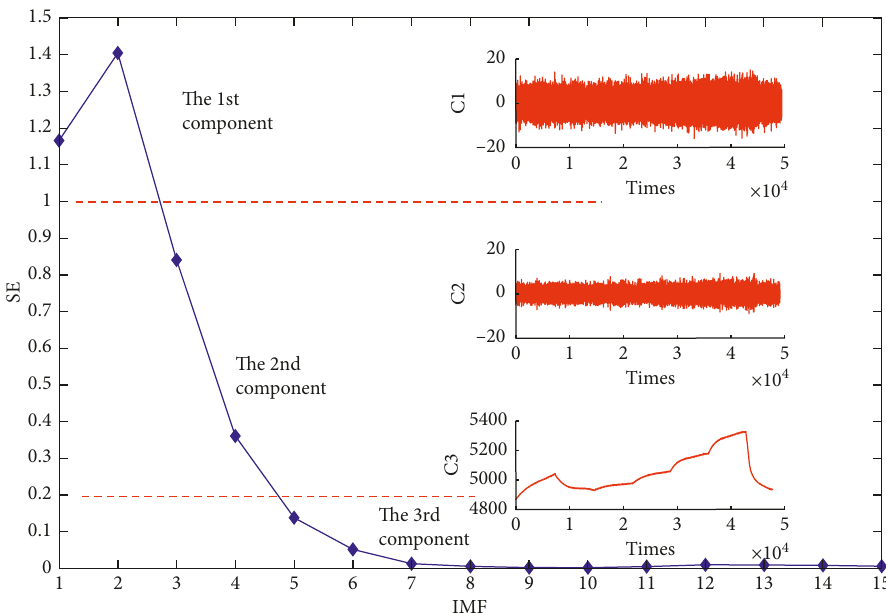
Figure 11: Stratification based on sample